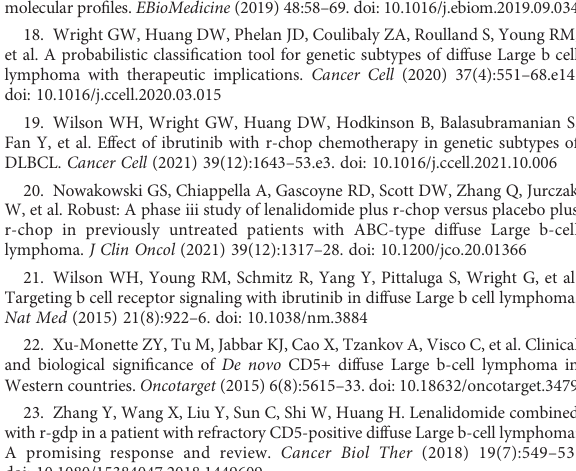
SUPPLEMENTARY FIGURE 3 mRNA expression of nine genes showed a signi fi cant correlation with OS, including (A) LIMD1 , (B) CYB5R2 , (C) RAB7L1 , (D) MME , (E) SERPINA9 , (F) ABS13 , (G) MAML3 , (H) MYBL1 , and (I) S1PR2 .